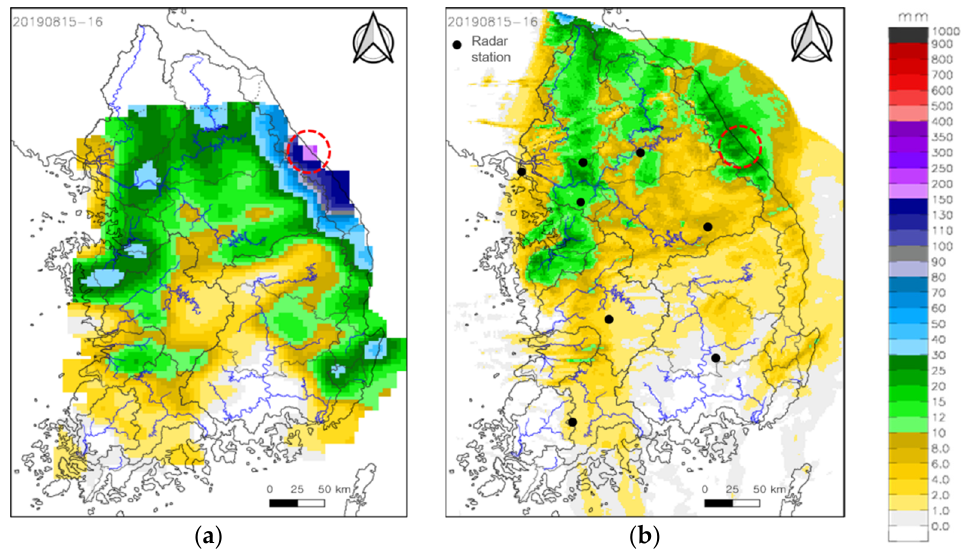
Figure 1. Accumulated rainfall distribution from 15 to 16 August 2019. ( a ) Distributed rainfall field by ground rain-gauge network; ( b ) Rainfall field by S-band radar network.